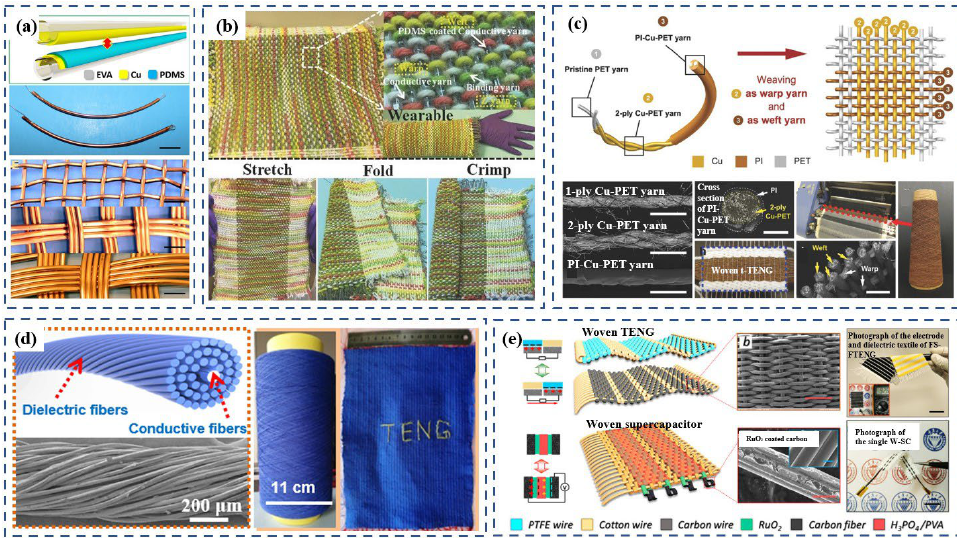
Figure 2. ( a ) TENG fabricated from a Cu-coated ethylene vinyl acetate (EVA) electrode and a polydimethylsiloxane (PDMS) covered Cu-coated EVA tubing electrode. Reproduced under the